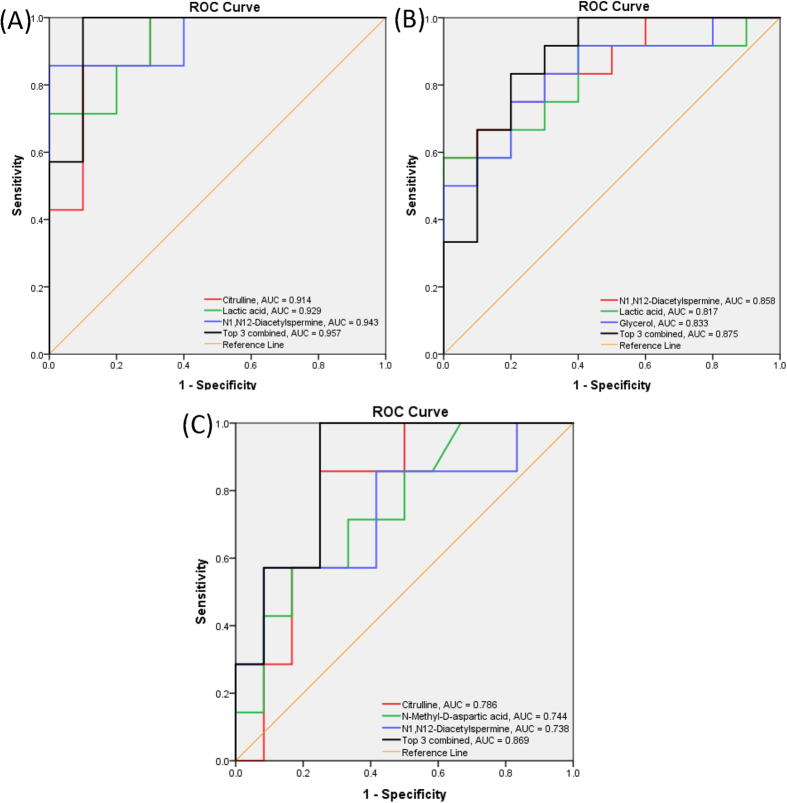
Receiver operating characteristic (ROC) curves summarizing the classification performance of three individual metabolites with highest AUC values, and their combined probability calculated from logistic regression. (A) Comparison between AIS A and C; (B) comparison between AIS A and B and (C) comparison between AIS B and C.